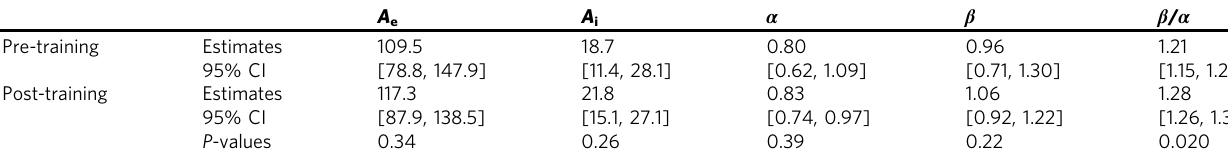
Table 2 Model parameters, comparing pre-training vs. post-training for the trained motion direction A